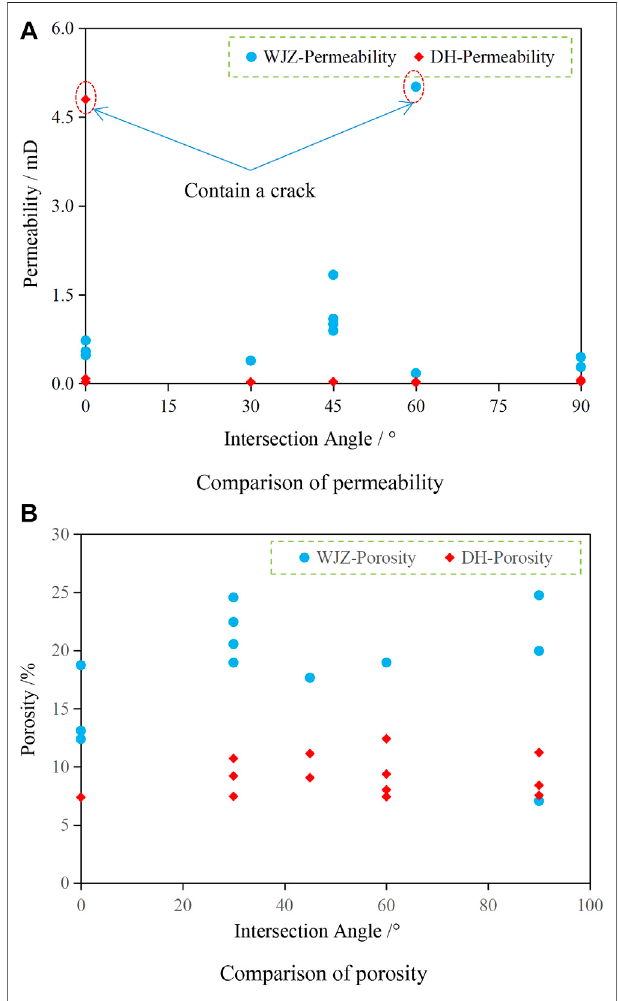
FIGURE6| Variationofporosity/permeabilitywithintersection angle. (A) Comparison of permeability. (B) Comparison of porosity.